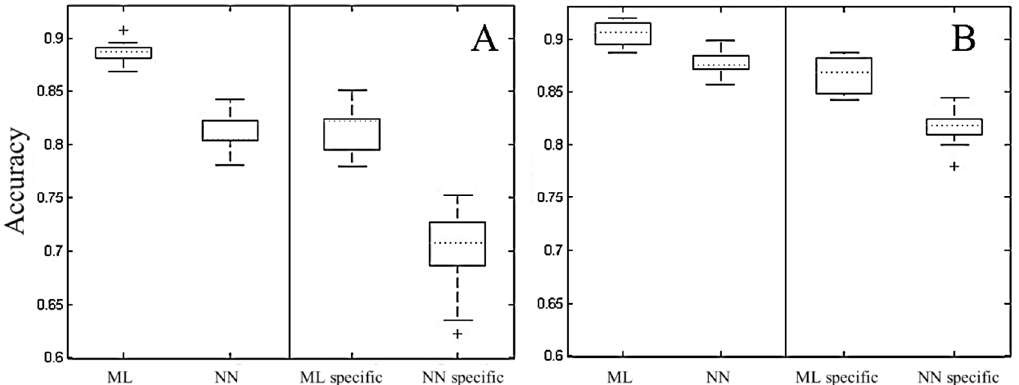
Figure 3. Box-plot of the accuracies for the Maximum Likelihood (ML) and neural network (NN) algorithms implemented for the image from 2004 ( A ) and 2011 ( B ). The overall accuracies are named “ML” and “NN”. The specific accuracies are named “ML specific” and “NN specific”. These results were obtained with the five iterations of the cross-validation technique.